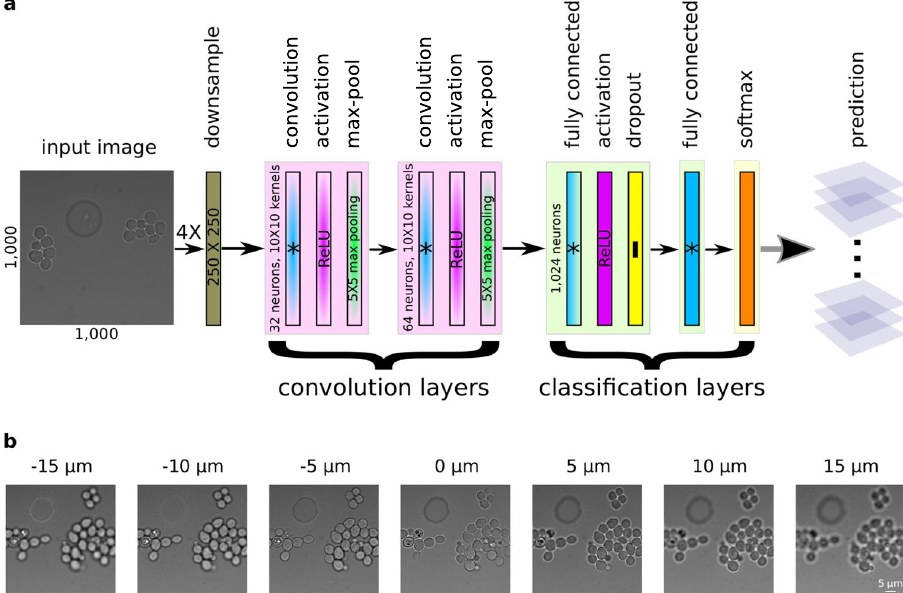
Figure 1. Autofocus convolutional neural network. ( a ) Architecture of the convolutional neural network (CNN). Images of 1000 × 1000 pixels in size are downsampled before entering the neural network. The CNN consists of two convolution blocks and two fully connected layers. ( b ) Sample images from a z-stack. Each z-stack is composed of 31 images in steps of Δ z = 1 μ m, including images below and above the focal plane ( z = 0). The complete z-stack is shown in Fig.